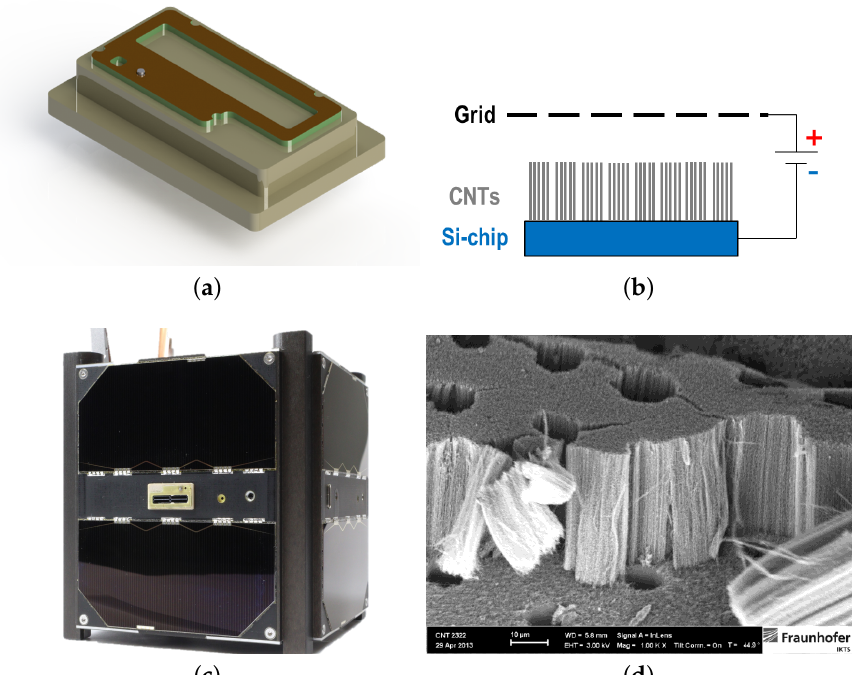
Figure 4. Details of the employed neutralizer ( a ) CAD model of a neutralizer. ( b ) Working principle of the electron source [20]. ( c ) Neutralizer positioning in the UWE-4 CubeSat structure. ( d ) Scanning electron microscope image of carbon nanotubes (CNTs) deposed on a silicon chip